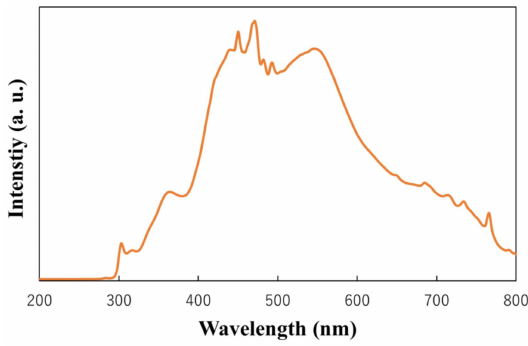
Figure 13. Light spectrum used to activate the